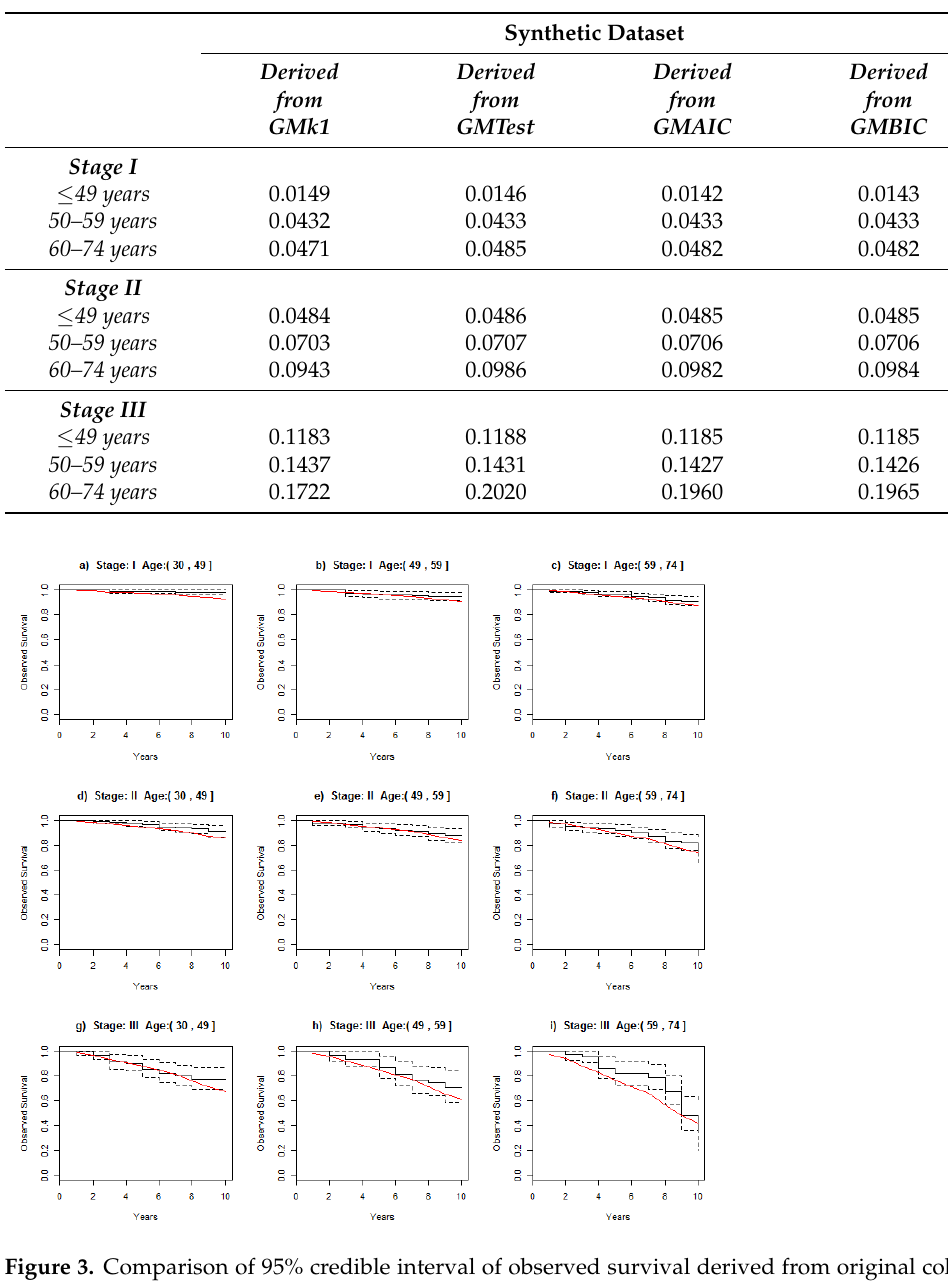
Table 2. Integrated Brier score at up to 10 years of follow-up by age and stage, comparing the cohort’s absolute survival with the absolute survival estimated using each one of the synthetic datasets derived from the Graphical Models (in bold: minimal integrated Brier score for each age group according to stage of breast cancer at diagnosis).